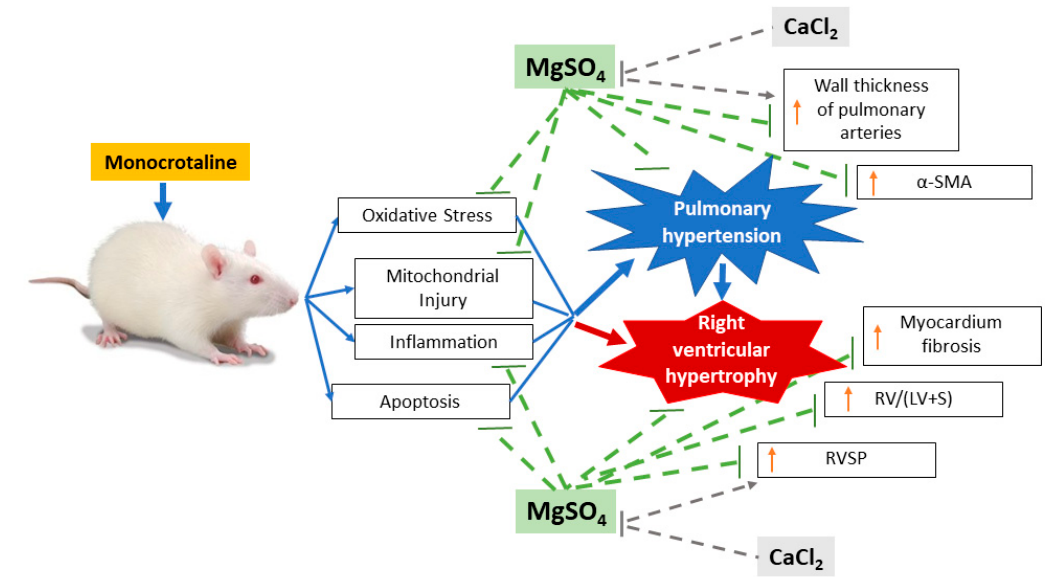
Figure 9. Illustration of the e ff ects of magnesium sulfate (MgSO 4 ) on inhibiting monocrotaline-induced pulmonary hypertension and right ventricular hypertrophy in rats. Counteracting e ff ects of calcium chloride (CaCl 2 ) on the therapeutic e ff ects of MgSO 4 are also illustrated. α -SMA: α -smooth msucle actin. RV / (LV + S): the weight ratio of right ventricle to left ventricle plus septum. RVSP: right ventricular systolic pressure.